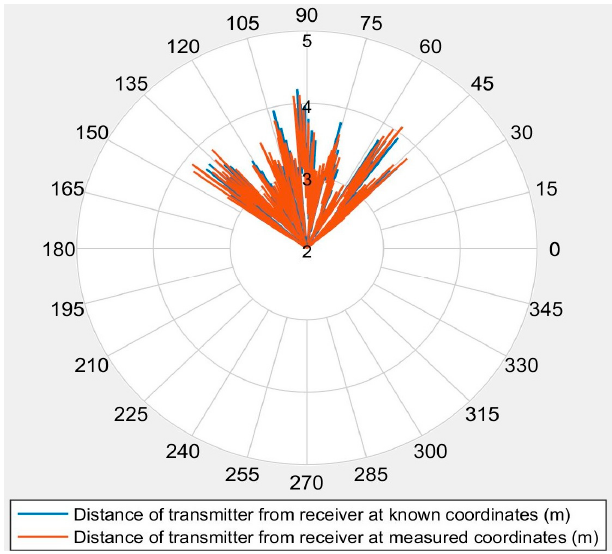
Figure 10. Angular range of the ultrasonic sensors.